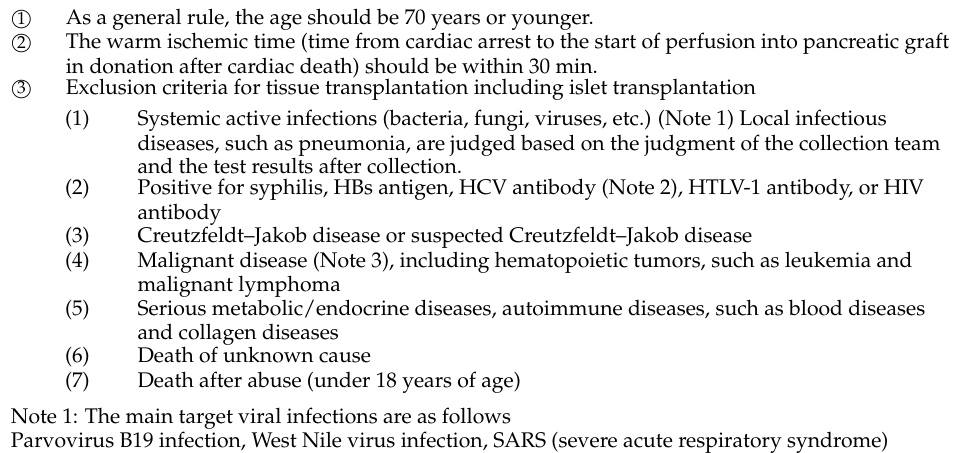
Table 1. Donor criteria for islet